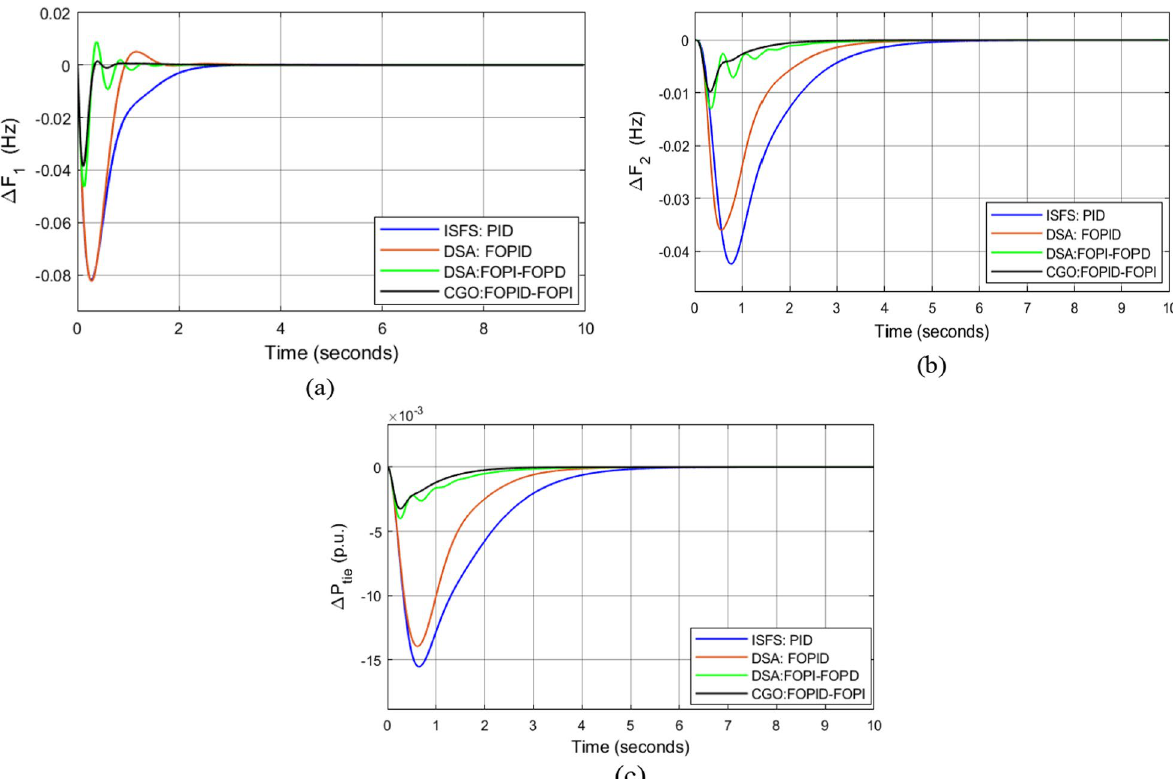
Fig. 8 Comparison of dynamic responses for Test-system 1 under 10% SLP in area 1: a ΔF 1 , b ΔF 2 , and c Δ P